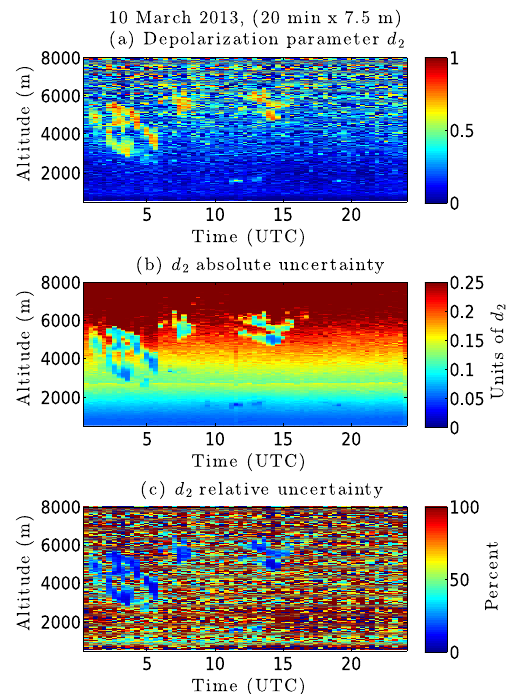
Figure 8. (a) The d 2 depolarization values from 10 March 2013, calculated at the same resolution (20min × 7.5m) as the d 1 val- ues shown in Fig. 3. Higher-resolution d 2 results follow in Fig. 11. (b) The uncertainties associated with the d 2 values are all in units of depolarization parameter. (c) The relative uncertainties are in units of percent. The current figure demonstrates two advantages of the d 2 method over the d 1 method when the resolution is kept constant: better coverage of time and space and lower uncertainty for each data